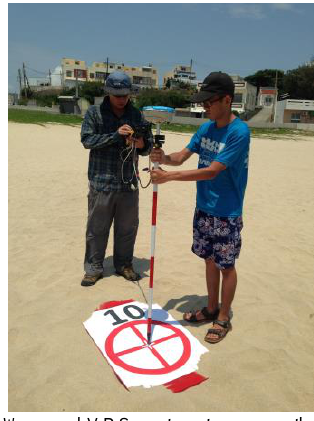
Figure 3. We used VRS system to survey the 18 GCPs